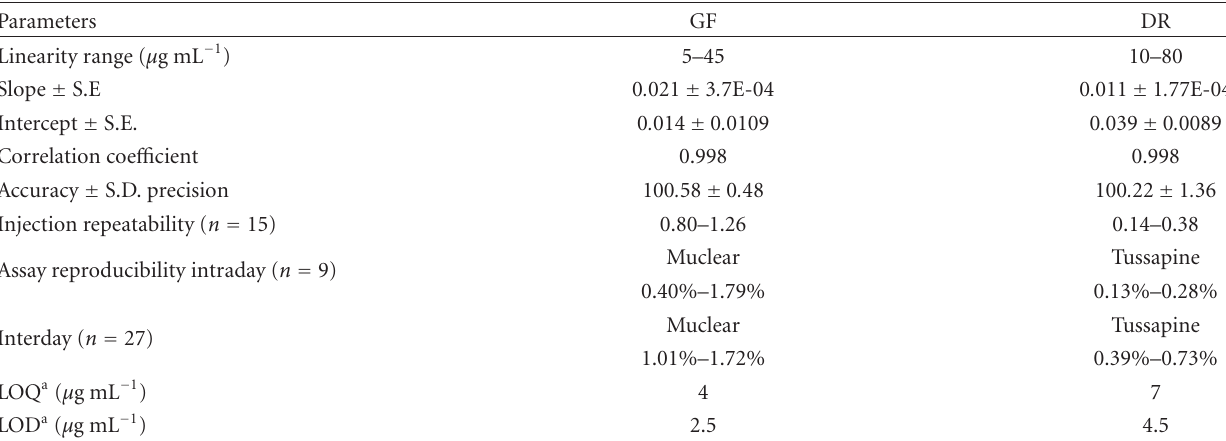
Table 1: Selected spectral data for the determination of guaifenesin and dropropizine by the proposed colorimetric method.